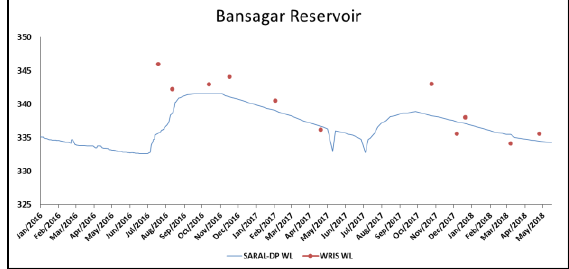
Figure 6. Saral Altika (drifting orbit, July-2016 to May-2018) water level time series for Bansagar